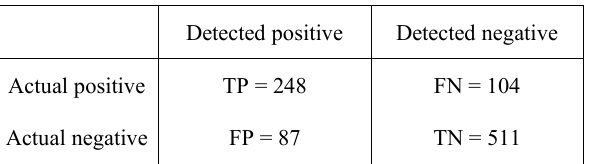
Table 3. The standard confusion matrix